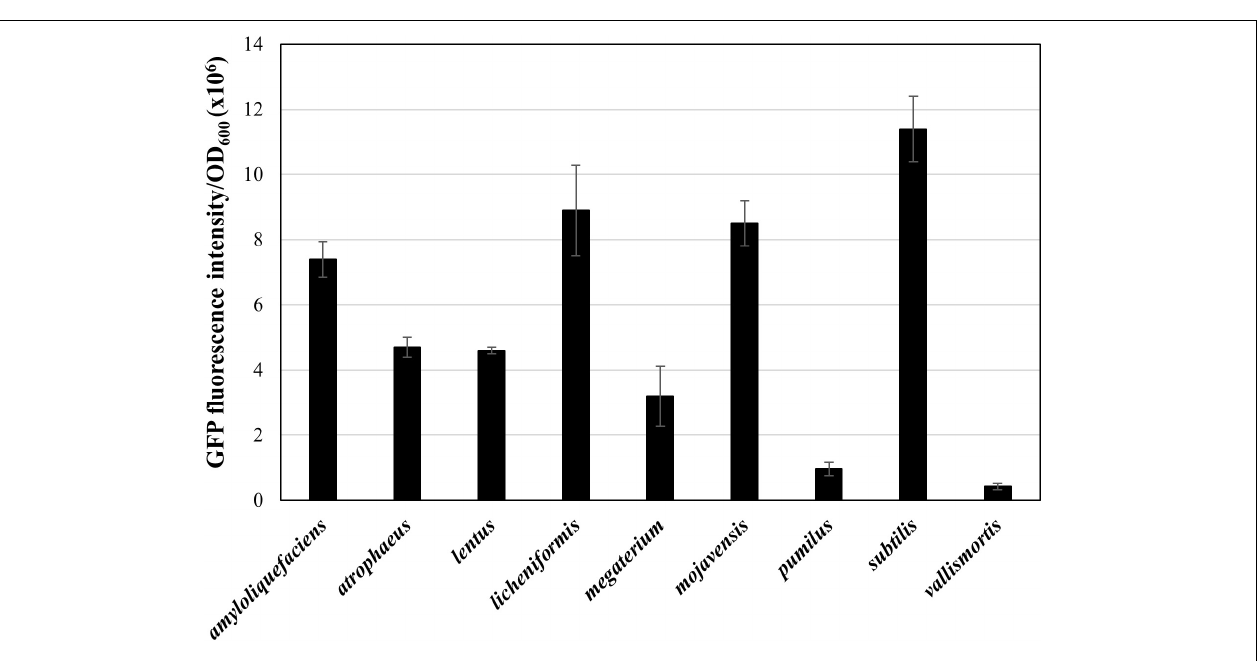
FIGURE 4 | Expression of GFP in QPS Bacillus strains. The GFP fluorescence reading was normalized to OD 600 = 1. The bars display the means of three independent measurements, with the error bars indicating standard